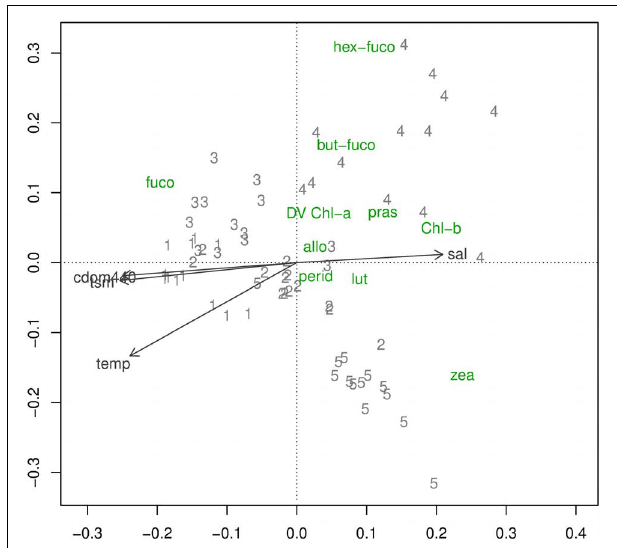
FIGURE 8 | Principal components analysis of indicator pigments by trip. PCA sample scores are plotted as trip numbers. Species scores are plotted as pigment codes. The arrows indicate environment variables. Refer to Table 2 for full names of the pigments and the taxonomic group they indicate.